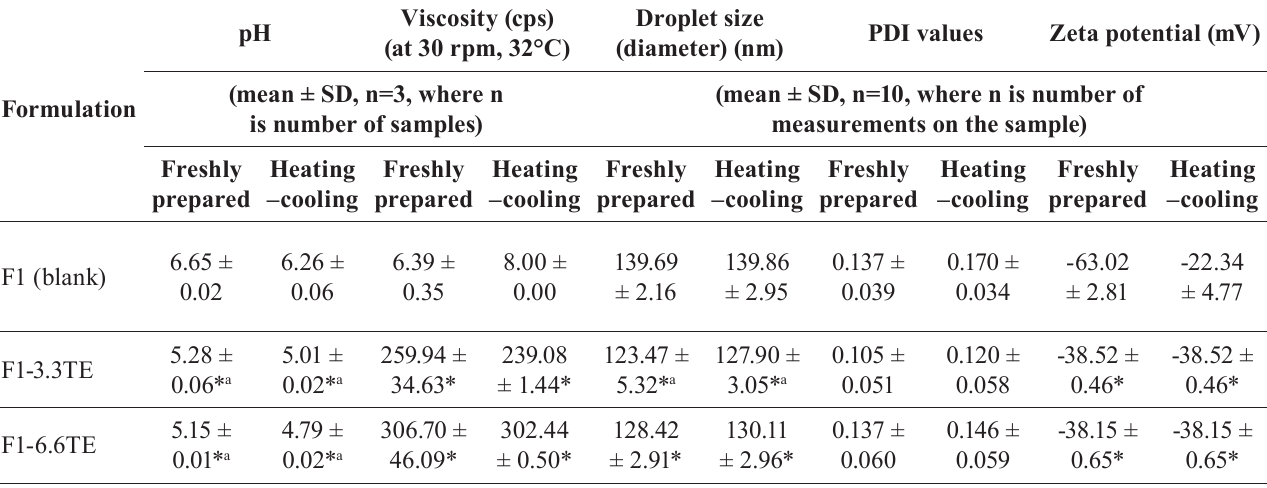
TABLE V - P hysicochemical property of tamarind extract loaded nanoemulsions compared with corresponding blank nanoemulsions